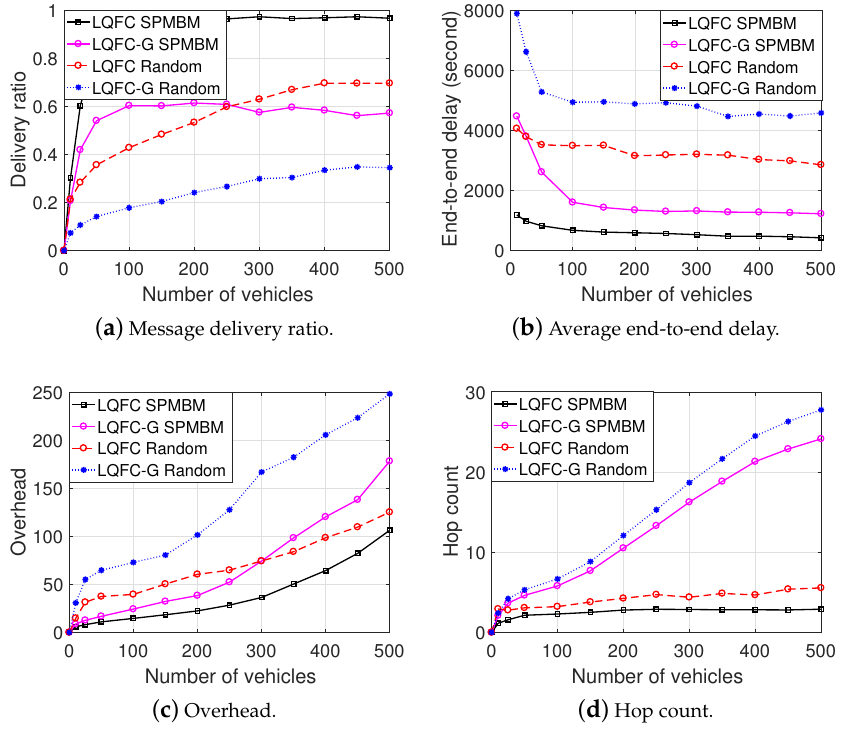
Figure 6. Network performance vs. mobility